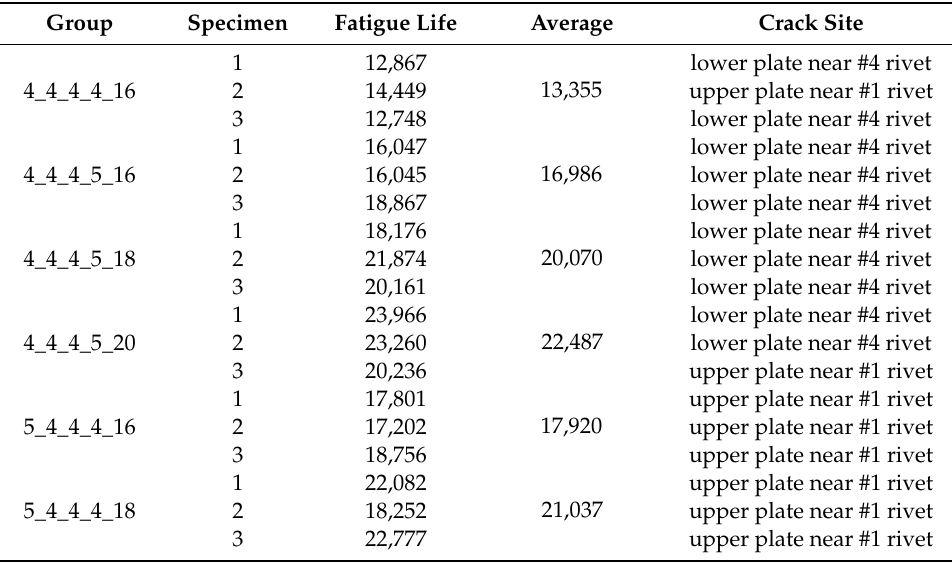
Table 8. The fatigue lives and crack sites of the riveted lap joints.